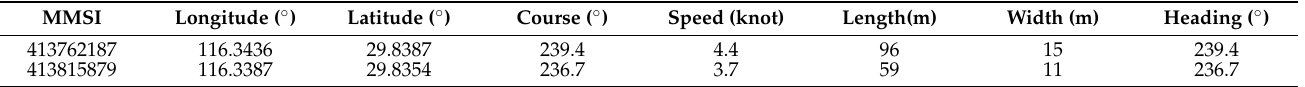
Table 4. Table 4. Table 4. AIS data of Case 2. Table 4. AIS data of Case 2.